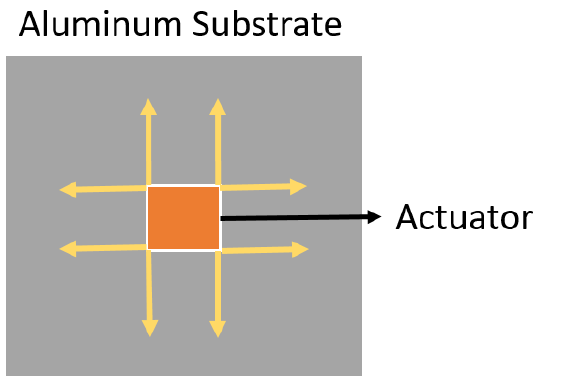
Figure 7. Representation of how the forces were simulated by discretizing and applying them to the edges of a square that has the same dimensions as the